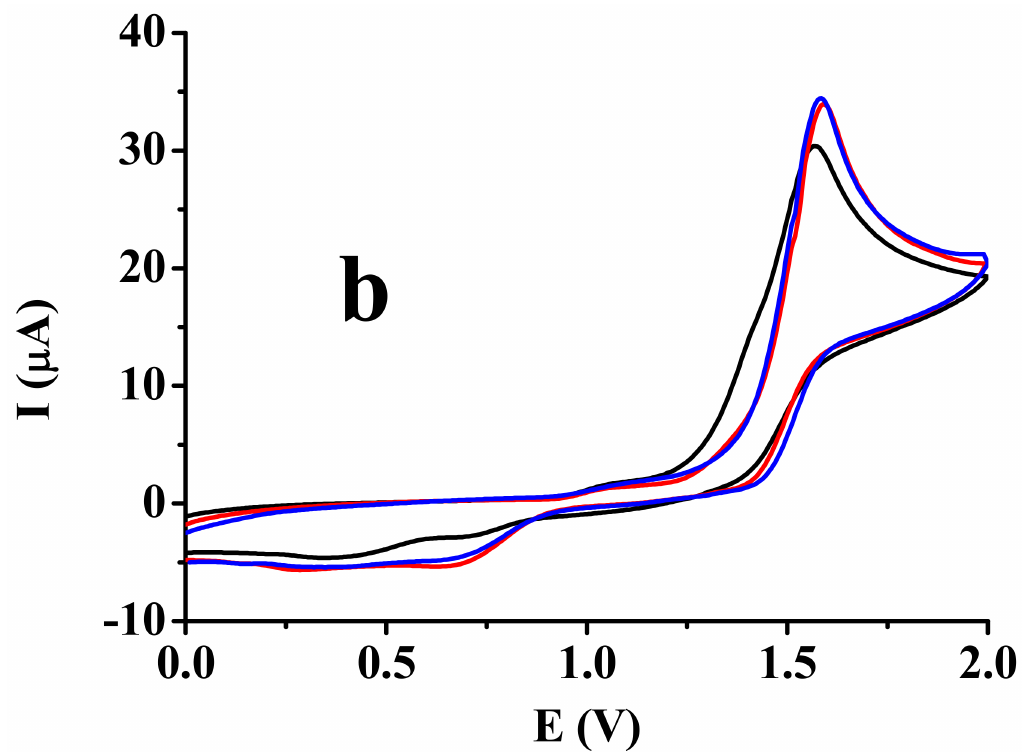
Figure 7. Cyclic voltammograms of 5 mM 4-methoxyphenol in the aqueous phase ( a ) (supporting electrolyte = 0.1 M at pH = 7 in phosphate buffer) and in acetonitrile ( b ) (supporting electrolyte = 20 mM TBAP) ( v = 0.1 V/s; black curve = bare electrode; red curve = electrode modified with poly(2-phenylphenol); blue curve = electrode modified with poly(2-phenylphenol) copolymer with the cavitand ( 1